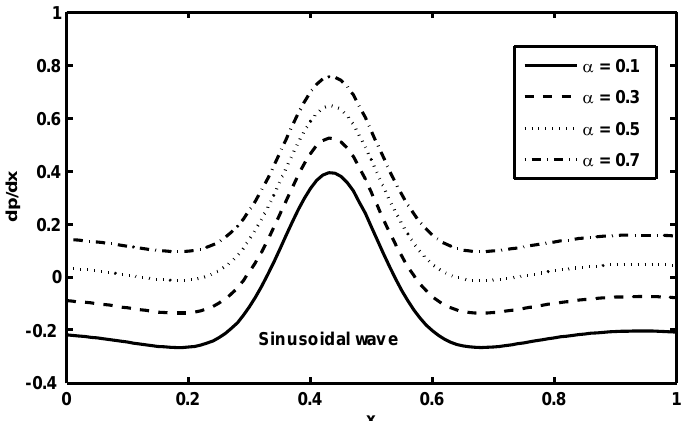
Figure 5. Variation of dp / dx with x for di ff erent values of α for fixed a = 0.7, b = 0.7, d = 1.5, Fr = 0.6, Θ = π